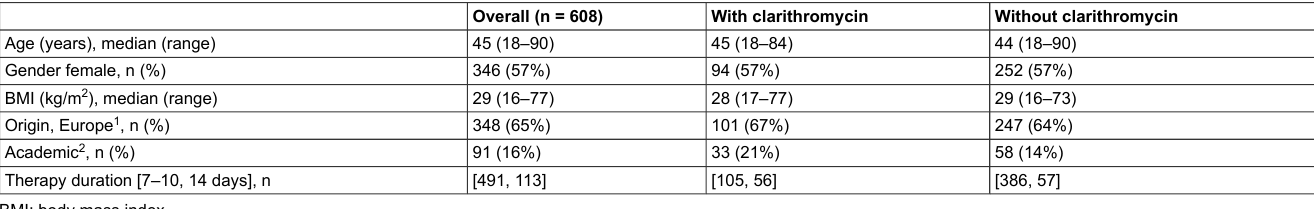
BMI: body mass index 1 Origin / place of birth was classified into the following categories: Europe vs middle east and other countries (South America, Africa, Asia, East [Russia, Ukraine, Armenia, Azerbaijan]) 2 Academic includes, for example, lawyer, medical doctor, professor, architect,